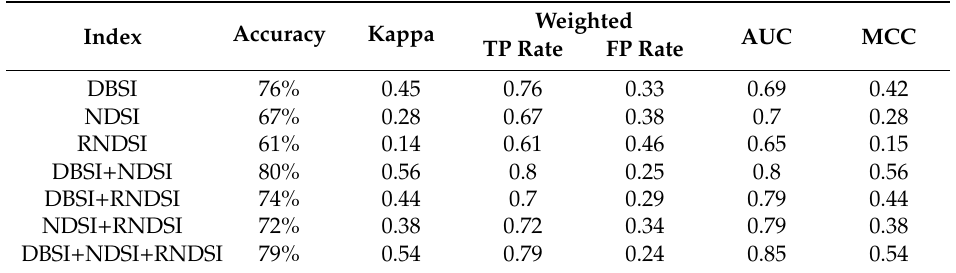
Table 3. Performance evaluation metrics of various indices (DBSI, NDSI, and RNDSI) against the land surface temperature derived from Landsat OLI images.